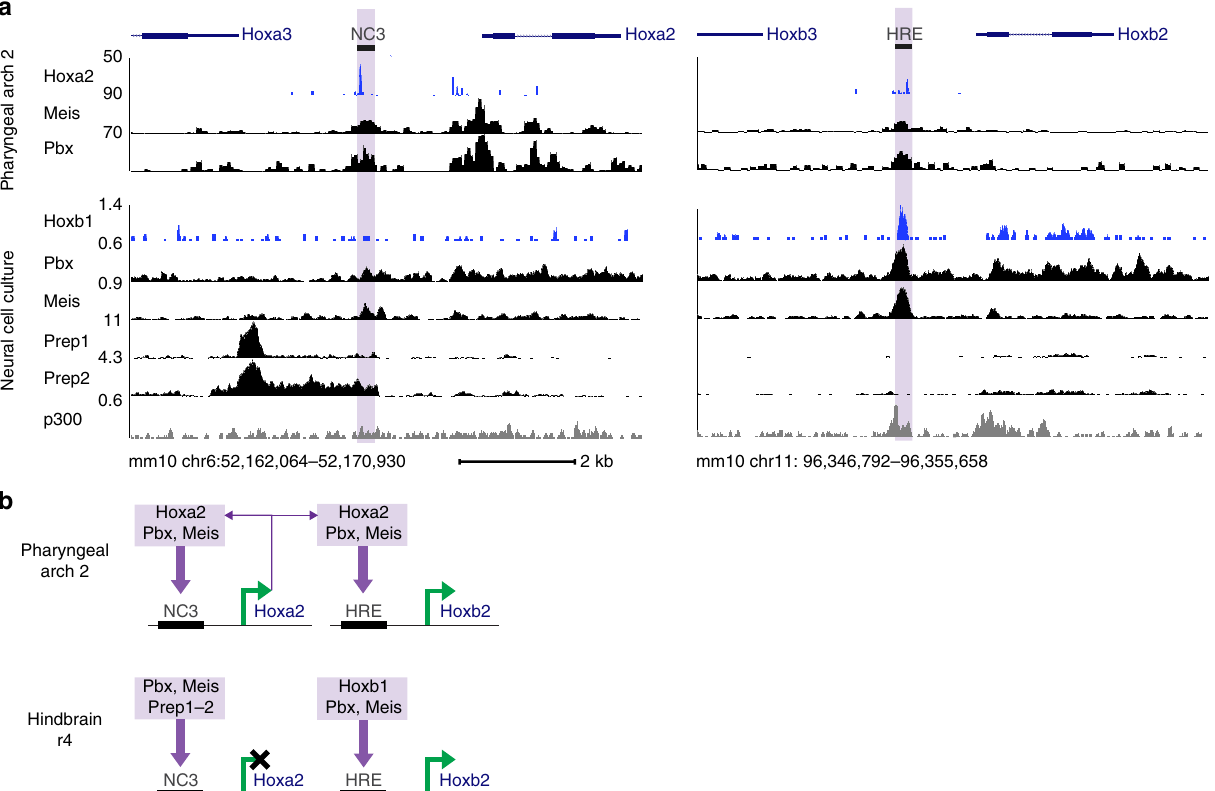
Fig. 7 Hoxa2 and Hoxb2 enhancers exhibit differential TALE (Three-Amino-Acid-Loop-Extension) and Hox binding correlating with their tissue-speci fi c activities. a DNA-binding pro fi les for Hox, TALE, and p300 factors in neural cell culture and pharyngeal arch 2 tissues at the mouse Hoxa2 ( NC3 ) and Hoxb2 ( HRE ) neural crest (NC) enhancers (highlighted in purple). Genes are annotated (top) and are transcribed from left-to-right. b Summary diagram of characterized differential regulatory inputs (purple arrows) from Hox and TALE factors (inferred from a ) into the mouse Hoxa2 and Hoxb2 NC enhancers in pharyngeal arch 2 (NC) and hindbrain r4 in vivo. Activation or inactivation of transcription is depicted by green arrows or a black cross, respectively. Purple arrows from the Hoxa2 gene indicate